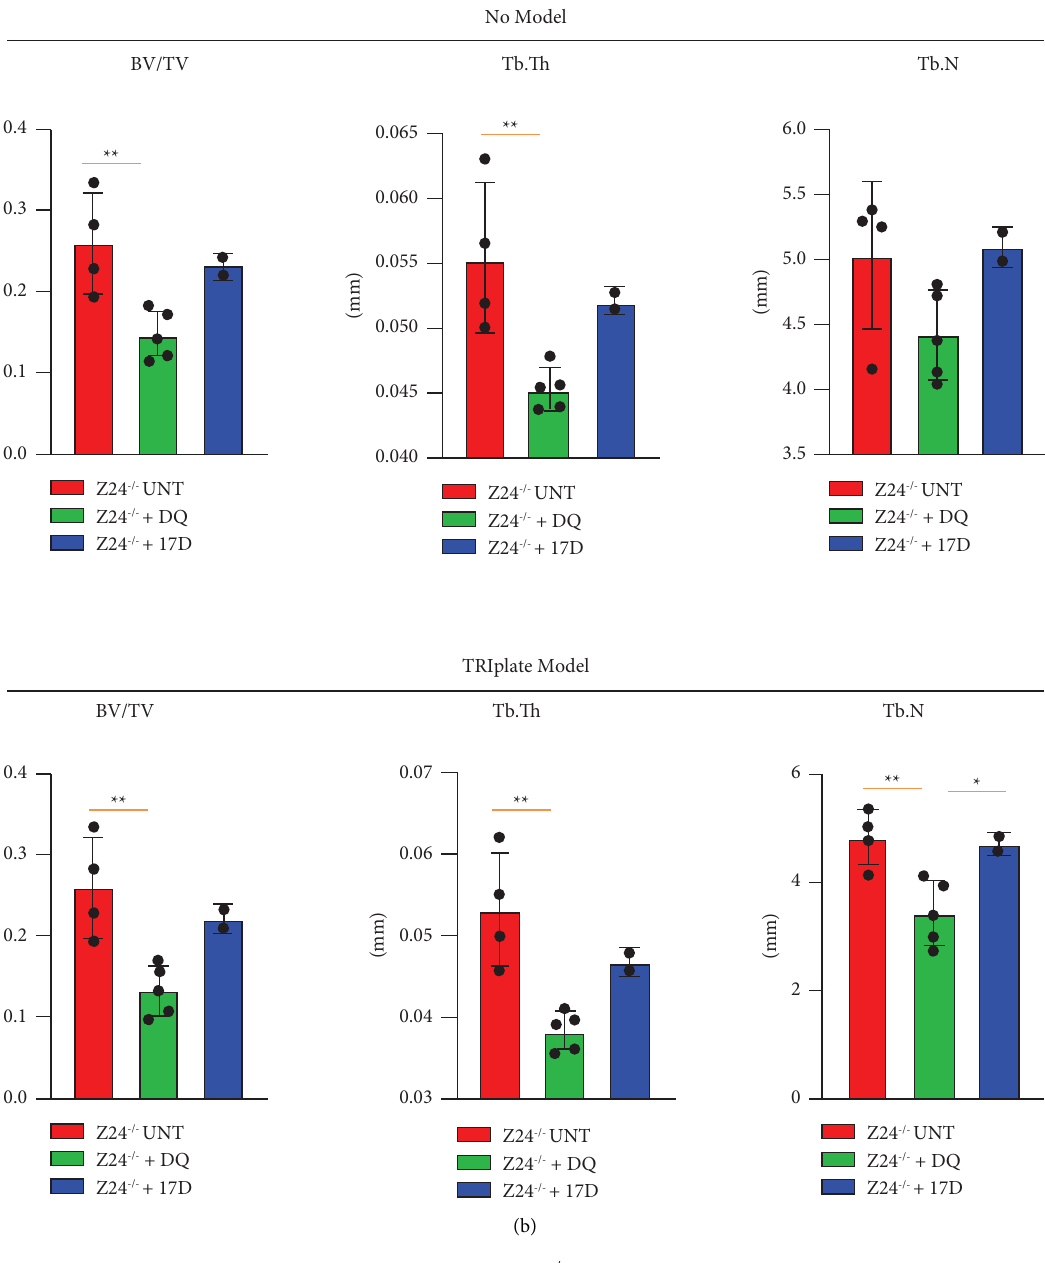
Figure 3: Diferential efects of other senolytic drugs on bone loss in Z24 − / − mice. (a) Micro-CT-generated bone morphometry of spine from Z24 − / − mice treated with DQ or 17-DMAG (17D) starting at 3 months of age. (b) Quantifed trabecular number (Tb. N), trabecular thickness (Tb. T), and bone volume fraction (BV/TV) per senolytic therapy (UNT, n � 4; DQ, 5 mg/kg D 50mg/kg; Q n � 5; 17-DMAG, 10mg/kg, n � 2; ∗∗ P < 0 . 01, ∗ P < 0 .